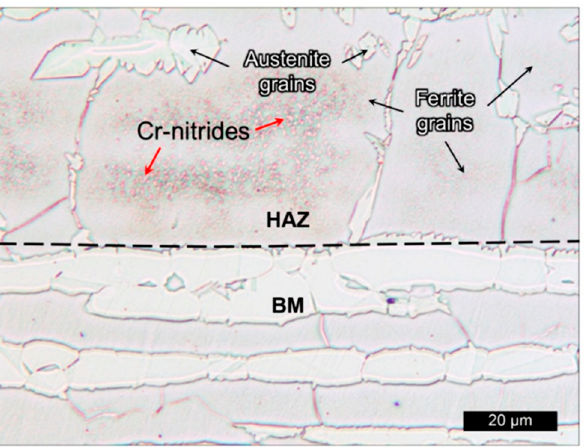
Figure 5. Chromium nitrides in HAZ in a SDSS 2507 superduplex steel (SDSS) as support plate (BM) and SDSS wire after WAAM process